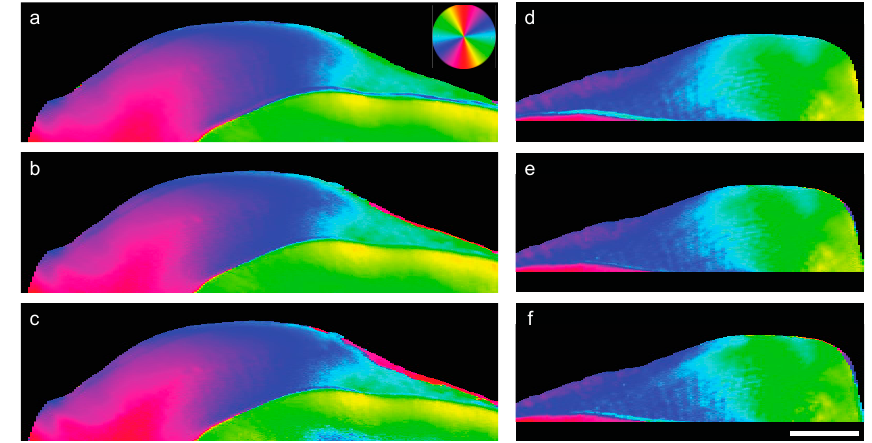
Figure 4. The color-coded images show the main azimuthal orientation of the scattering patterns for the q -ranges corresponding to the real-space periodicities between 10 and 20 nm ( a , d ), 70 and 80 nm ( b , e ), and 140 and 150 nm ( c , f ) for the natural ( left column ) and the artificial ( right column ) lesions. The direction of the scattered intensity is according to the color wheel in the inset. The carious lesions cannot readily be distinguished from the sound enamel, suggesting that the predominant orientation of the features on the investigated nanometer range is unaffected by the carious lesions generated. The scale bar corresponds to 1 mm.